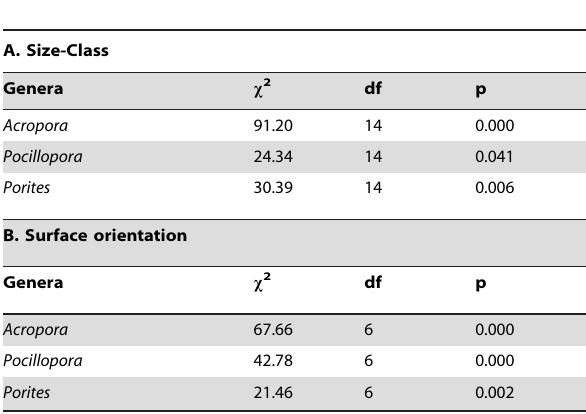
Table 3. Chi-square tests examining latitudinal variation in (A) size-class frequencies and (B) surface orientation of juvenile corals from the three main